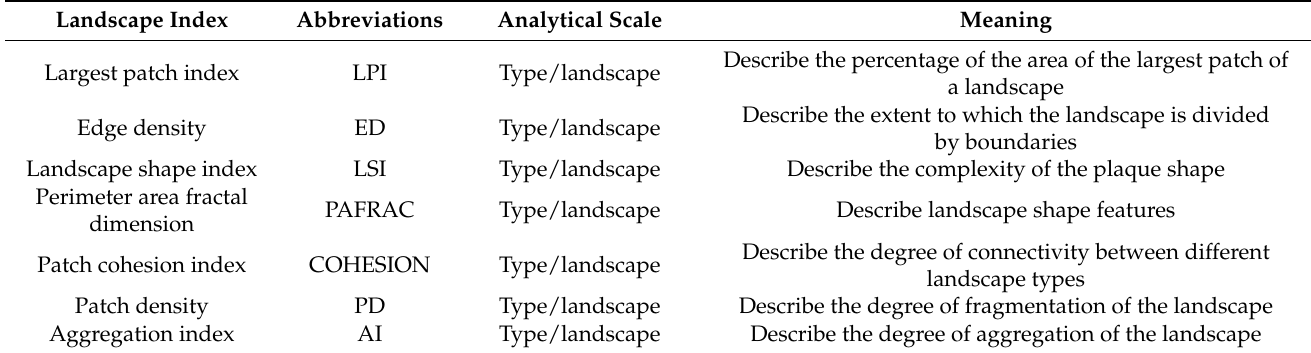
Table 1. Landscape index and